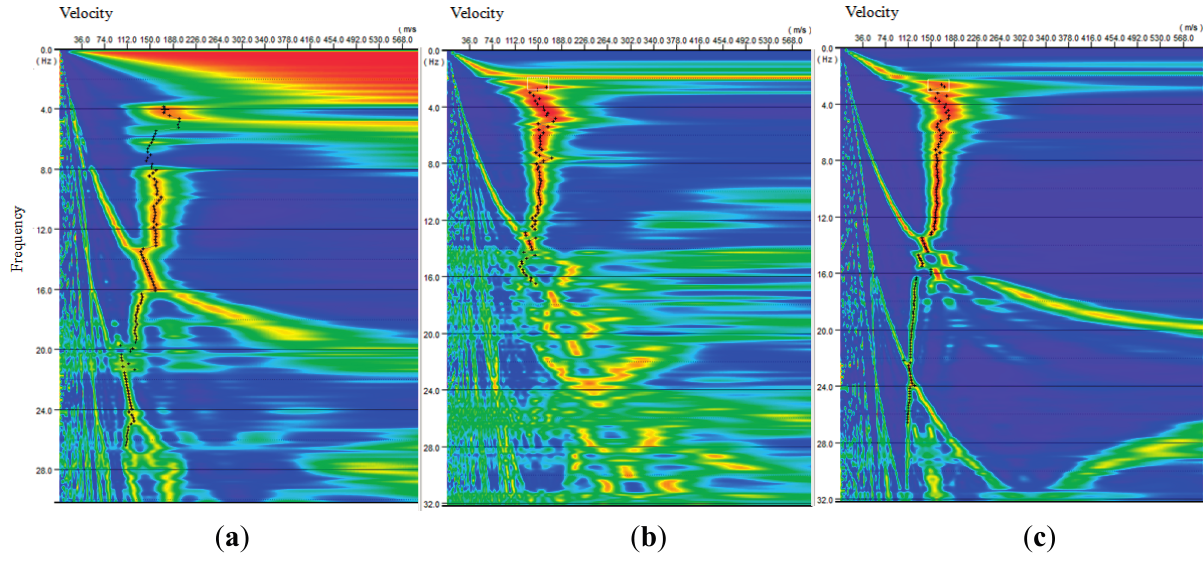
Figure 11. Dispersion images for recordings from: ( a ) accelerometer; ( b ) cableless geophone; and ( c ) 4.5 Hz